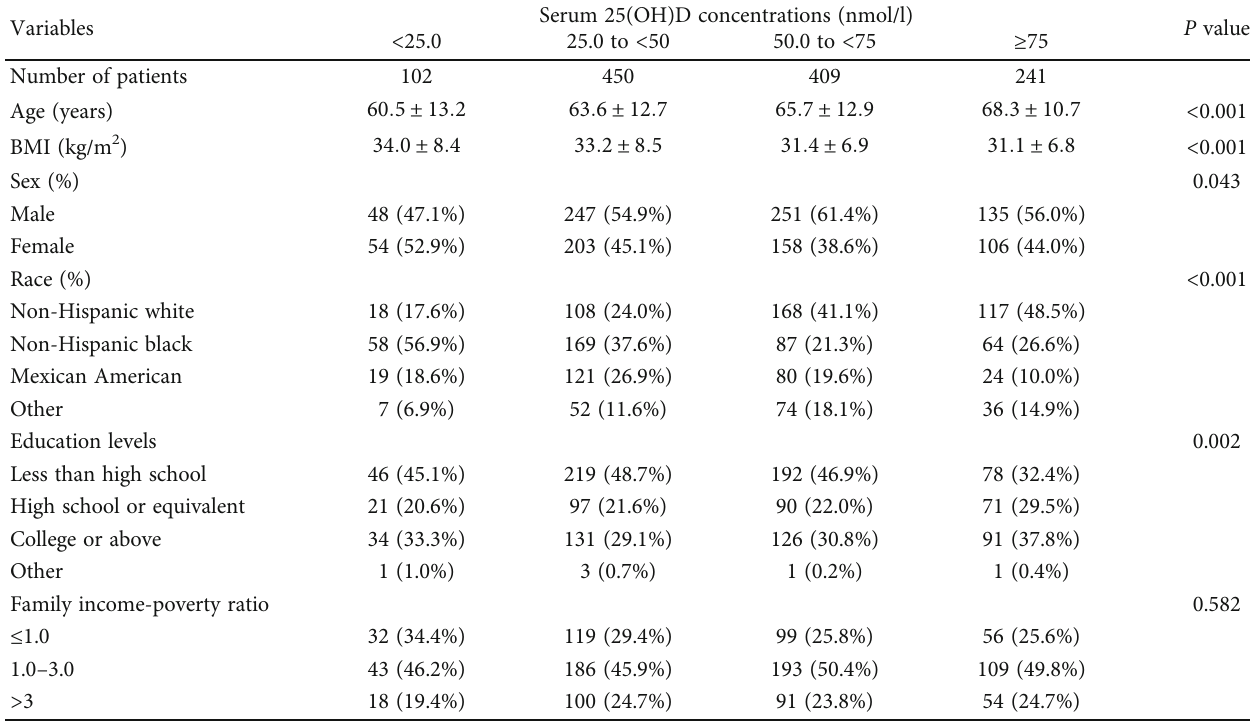
Table 1: Baseline characteristics of participants with DKD according to serum 25(OH)D concentrations in NHANES 2001 – 2014. Variables